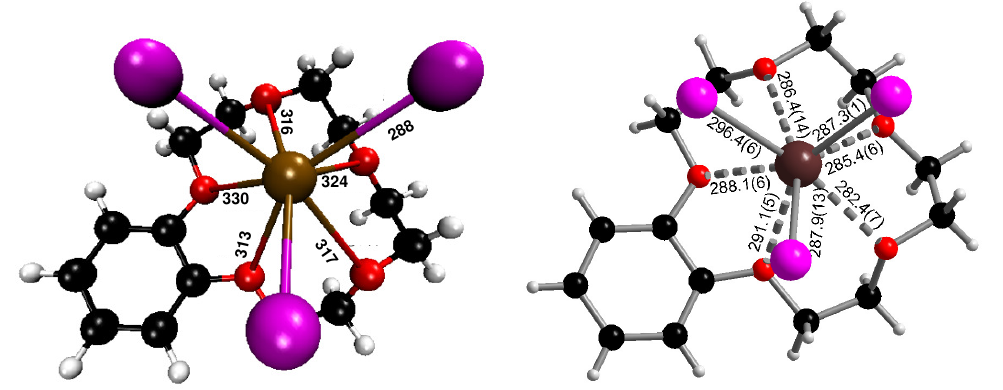
Figure 4. Optimized gas phase ground state geometry of (b15c5)BiI corresponding cut-out of the crystal structure of (b15c5)BiI interatomic distances are labeled in